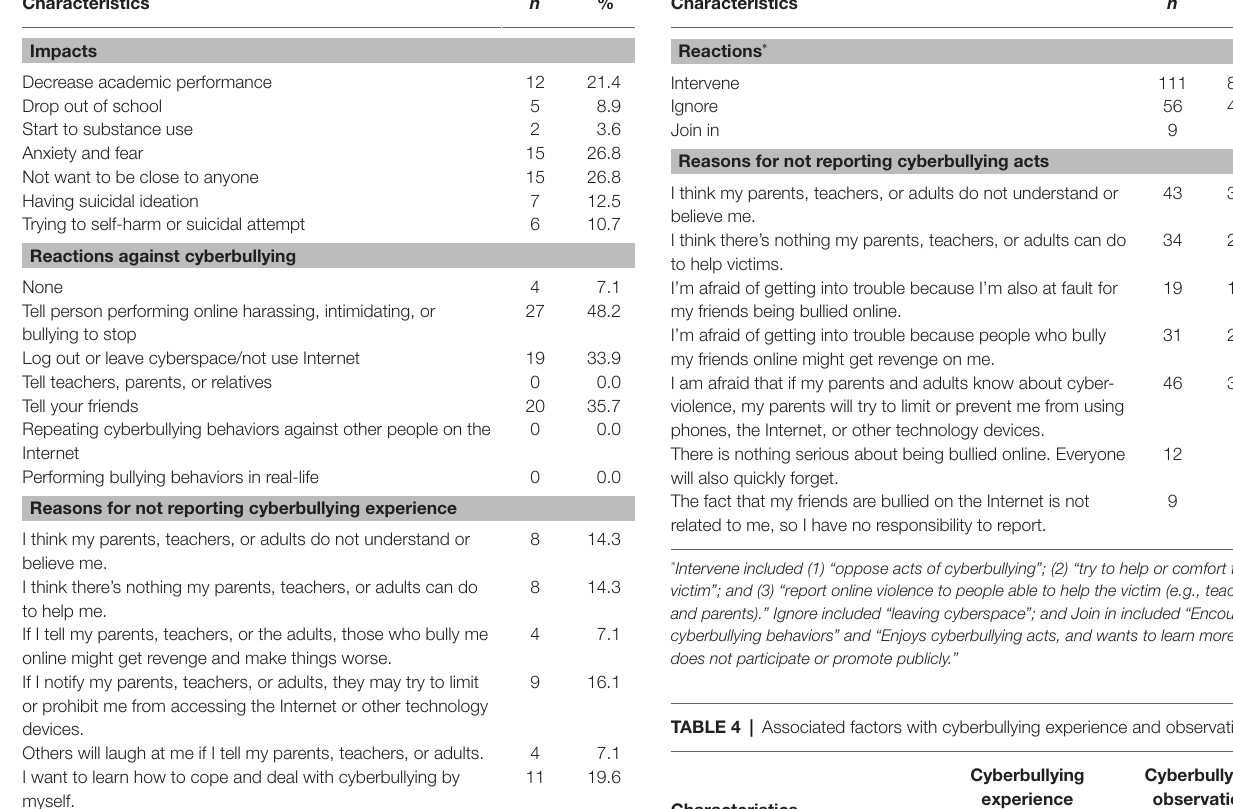
TABLE 2 | Impacts, reactions, supporters, and reasons for not reporting cyberbullying experience ( n = 56). Characteristics